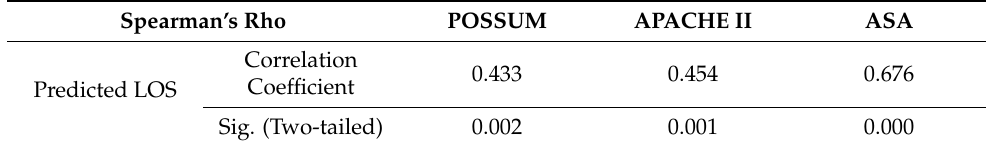
Table 3. Correlation between predicted LOS and POSSUM, APACHE II, ASA scale.